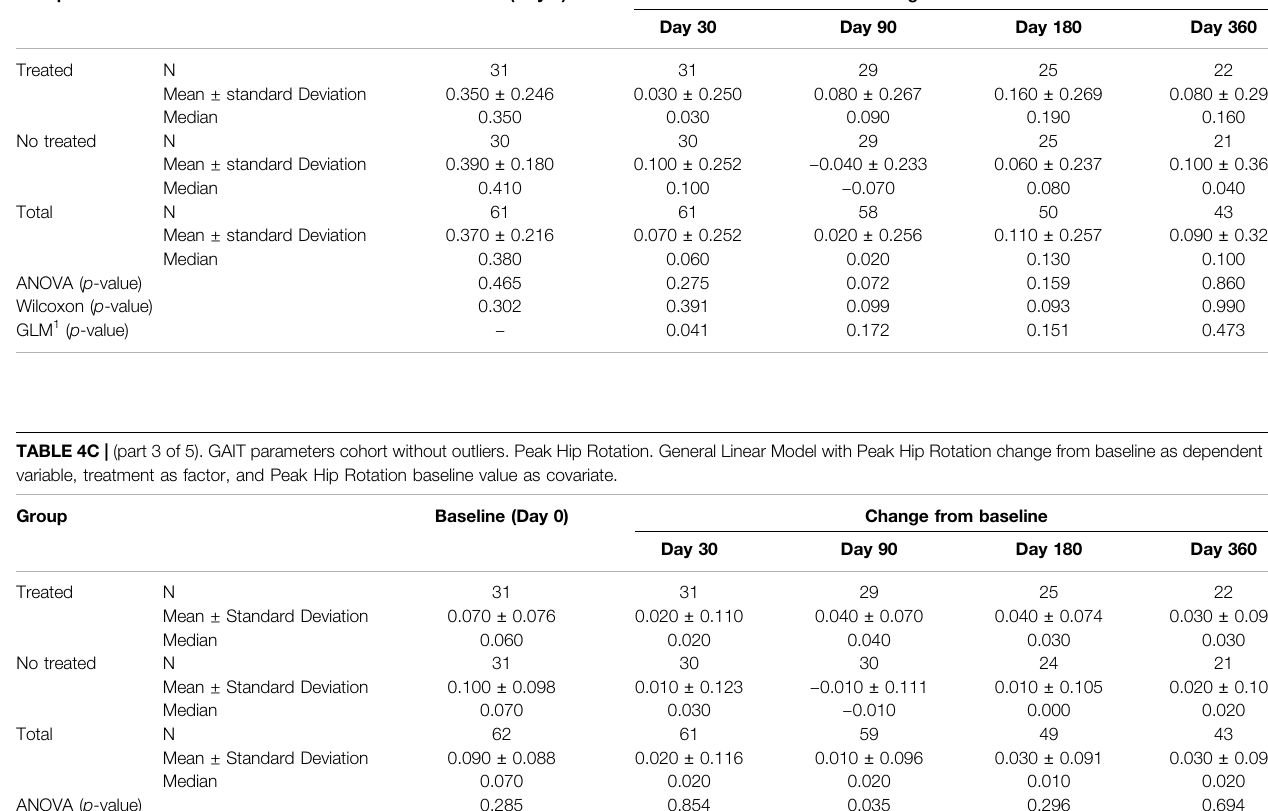
TABLE 4B | (part 2 of 5). GAIT parameters cohort without outliers. Peak Knee Valgus-Varus. General Linear Model with Peak Knee Valgus-Varus change from baseline as dependent variable, treatment as factor, and Peak Knee Valgus-Varus baseline value as covariate. Group